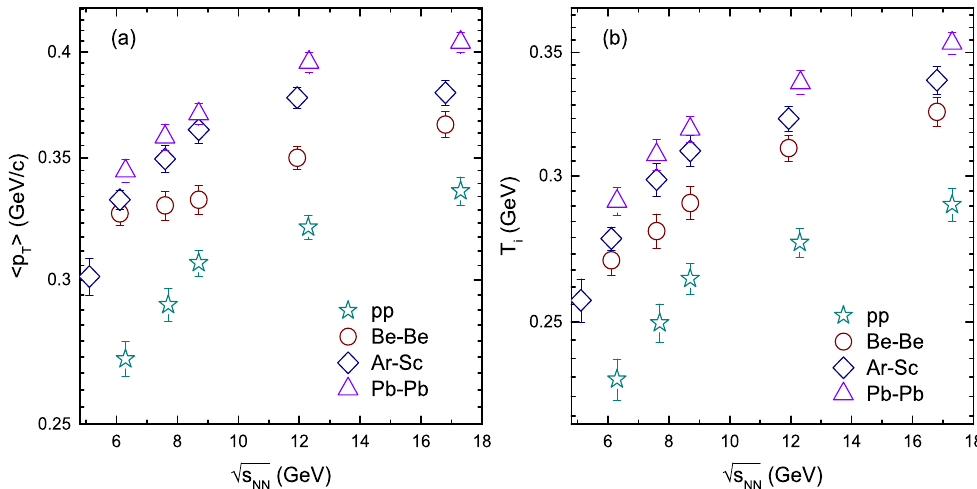
Figure 3. Dependence of ( a ) mean transverse momentum and ( b ) initial temperature on collision energy and collision cross-section.